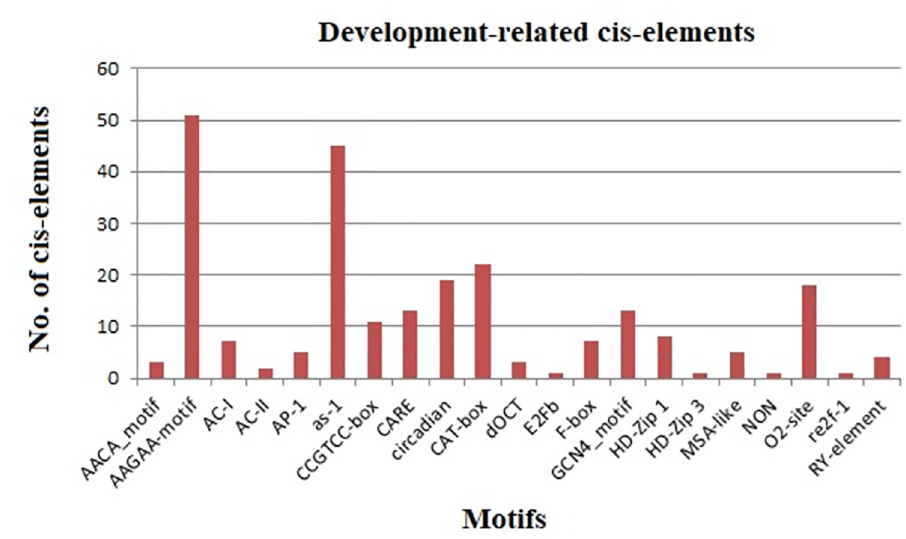
Fig 5. Histogram based representation of developmental-related elements in StDREBs. Results revealed 21 types of motifs with AAGAA-motif and as-1 showing maximum percentage in StDREB gene promoters.